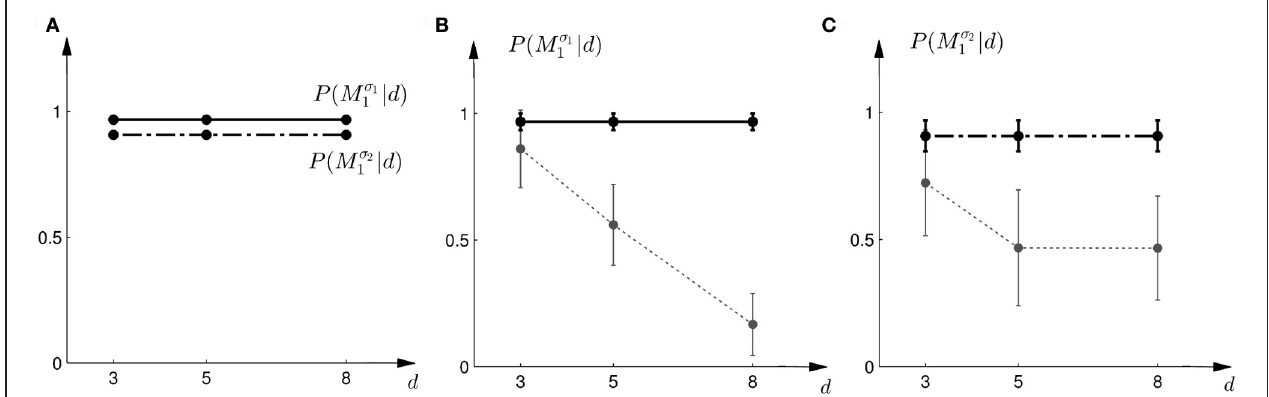
individually per subject, the predictions show the mean across all subjects. The corresponding standard deviation error bars are shown in panels (B,C) . (B) Shows the predictions for the first part of the study (solid line) and the experimental results for three different widths d of the ambiguous feedback array. The dotted line shows the mean and standard deviation across subjects of the experimentally observed probabilities of choosing M σ 1 1 . (C) Shows the predictions (dash-dot line) as well as the experimentally observed choice probabilities (dotted line) for choosing M σ 2 1 in the second part of the study.